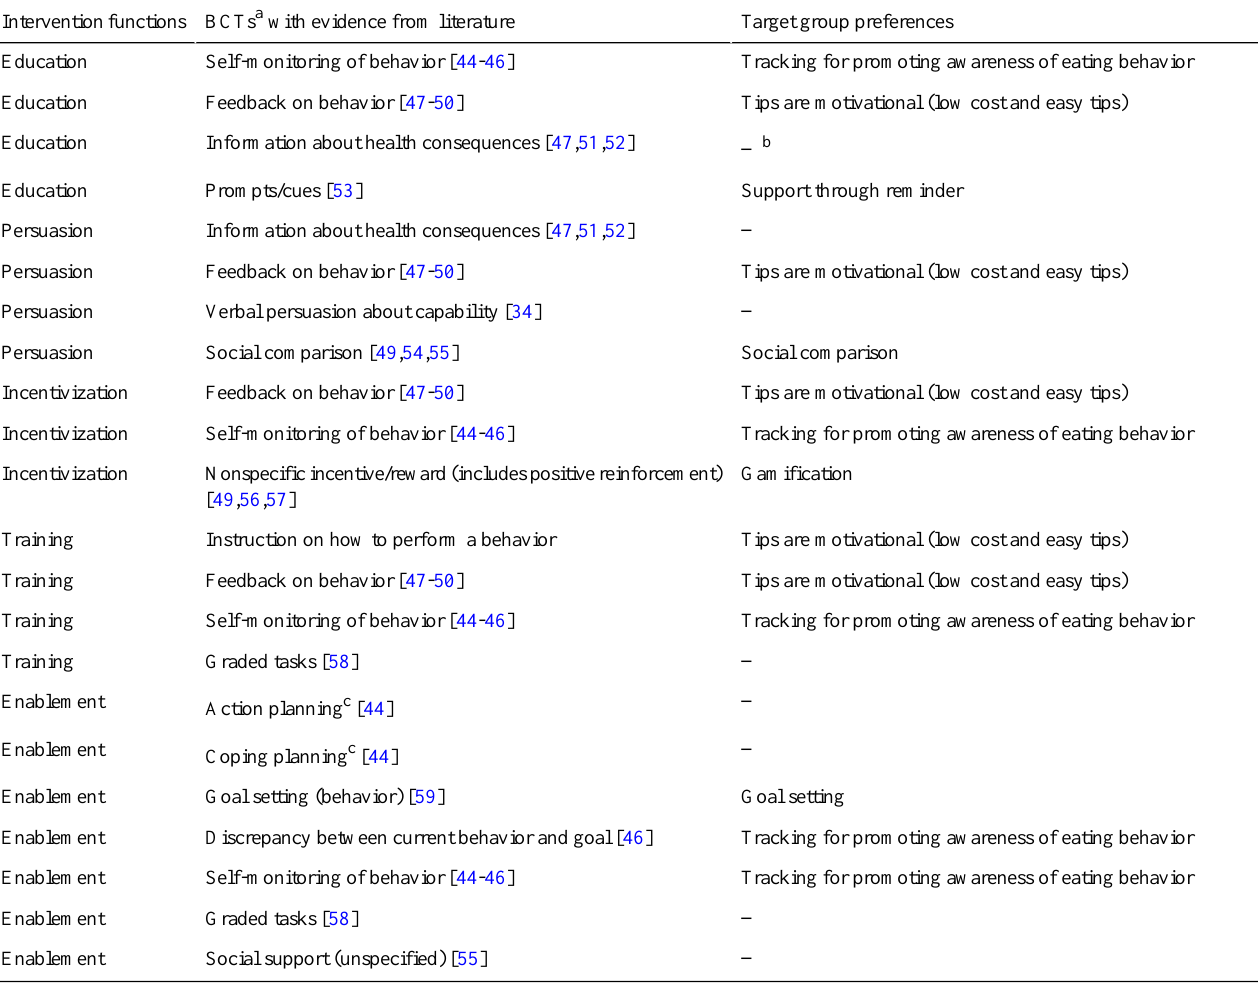
Table 3. Intervention functions with capability-opportunity-motivation-behavior components and behavior change techniques (including evidence of effectiveness and target group